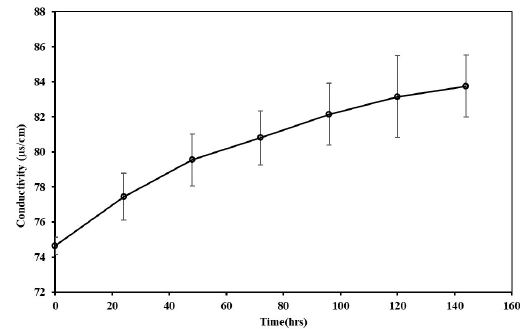
Figure 3. Time profile of electrical conductivity for tap water circulating through the magnetic field (MW).